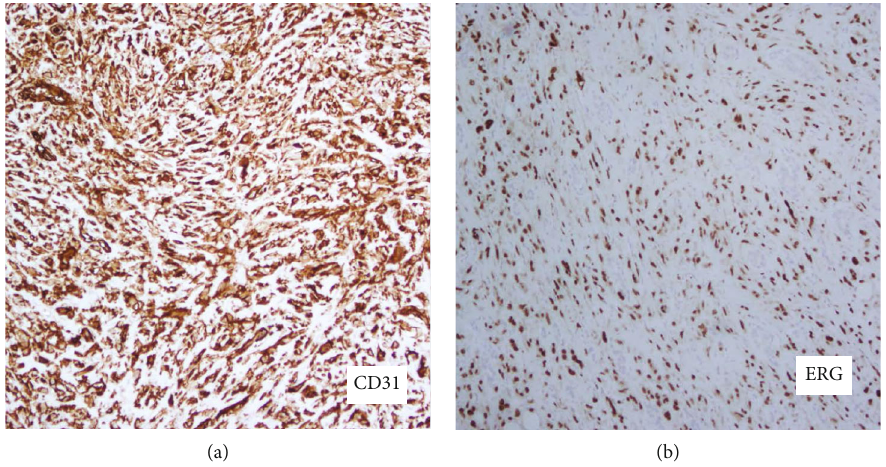
Figure 3: Positive immunohistochemistry for (a) CD31 and (b) ERG